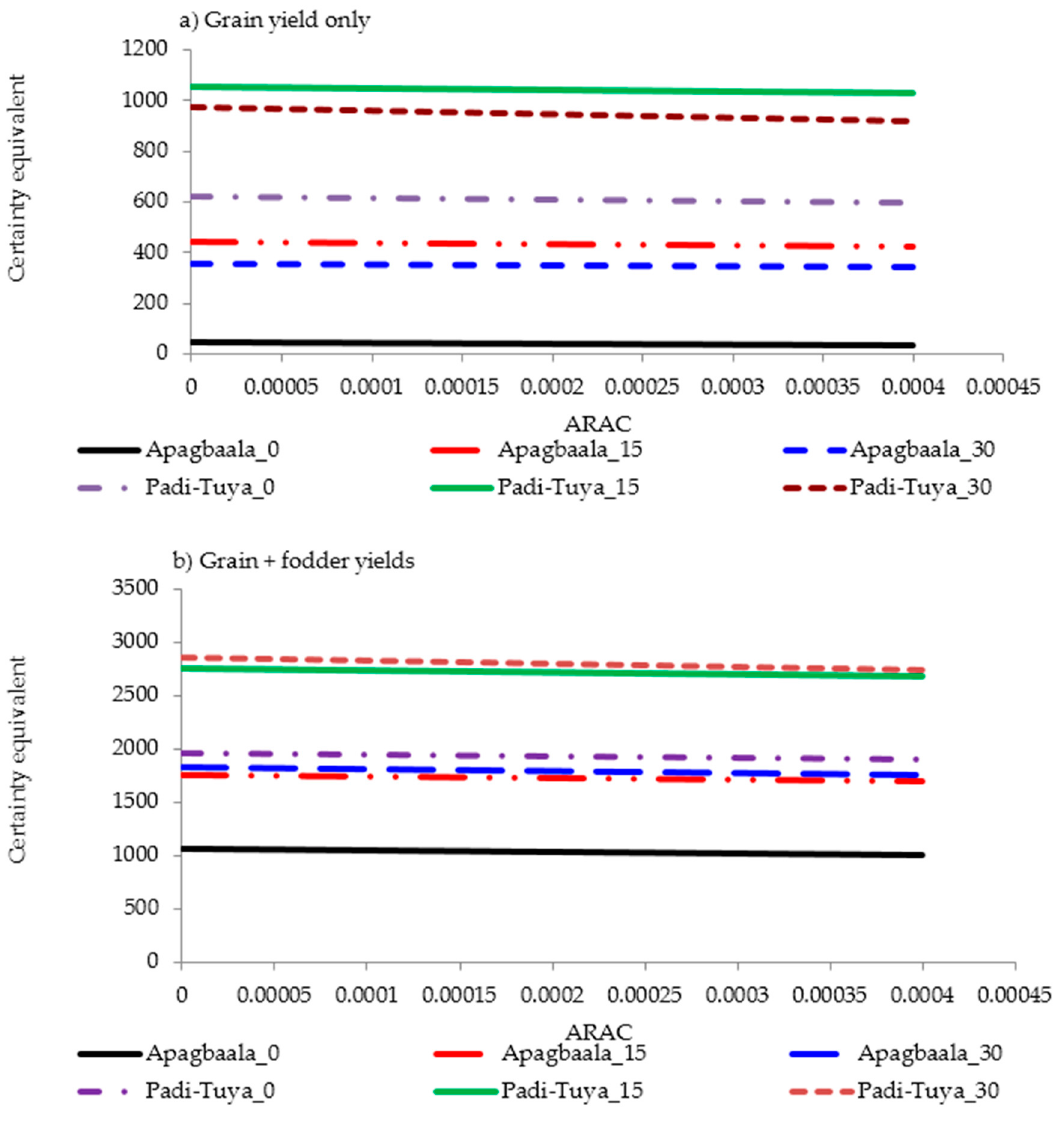
Figure 3. SERF of net returns.